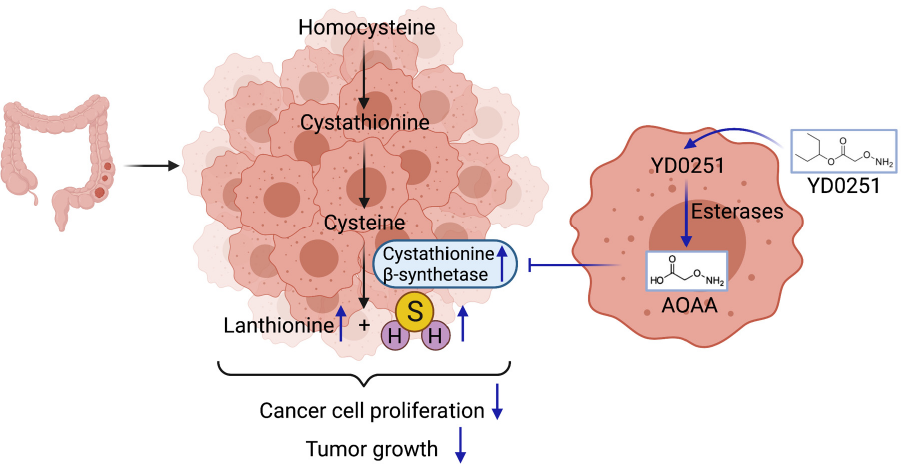
Figure 11. Mechanism of YD0251’s action in colon cancer cells. YD0251, due to its high lipophilicity, readily enters cancer cells. After conversion by esterases, AOAA is released, which in turn inhibits intratumor CBS activity, decreases tumoral H 2 S levels, and exerts antitumor actions in vitro and in vivo. These effects are most pronounced in tumors with higher CBS expression.